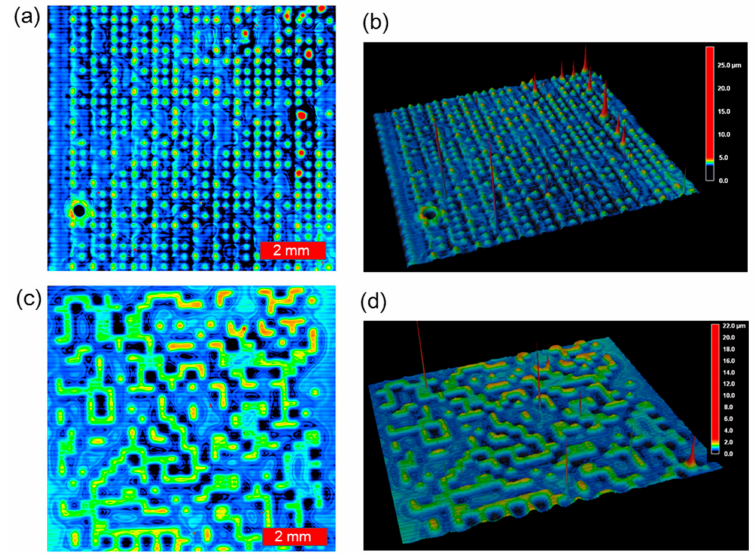
Figure 9. Wide-area measurement of surface modulations for ( a , b ) Gaussian-like and ( c , d ) continuous Gaussian-like random phase